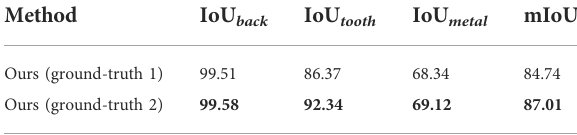
TABLE 4 Our method was tested on different ground-truth. Bold values indicates the best performing